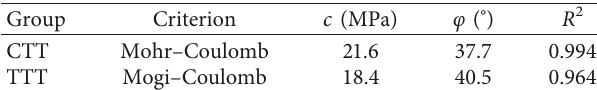
Table 2: Fitting results and parameter values of two strength criteria of sandstone.